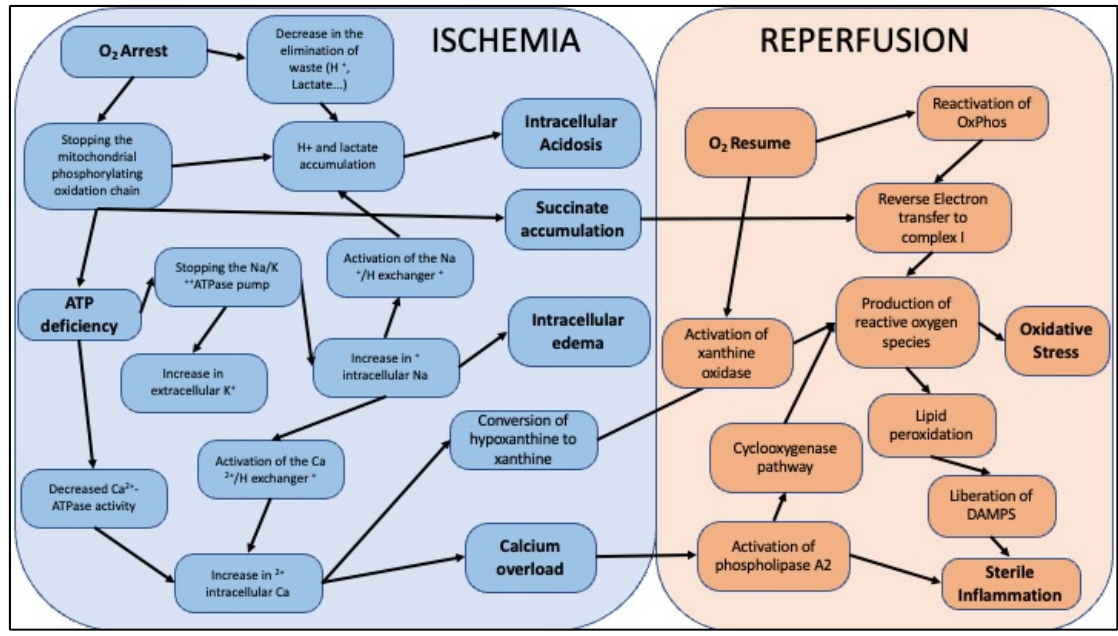
Figure 4. Cellular impacts of ischemia reperfusion. The sequence of events taking place during ischemia reperfusion is displayed, from the arrest of oxygen supply and consequences during ischemia, to the oxidative stress resulting from resumption of oxygen supply and the resulting sterile inflammation.